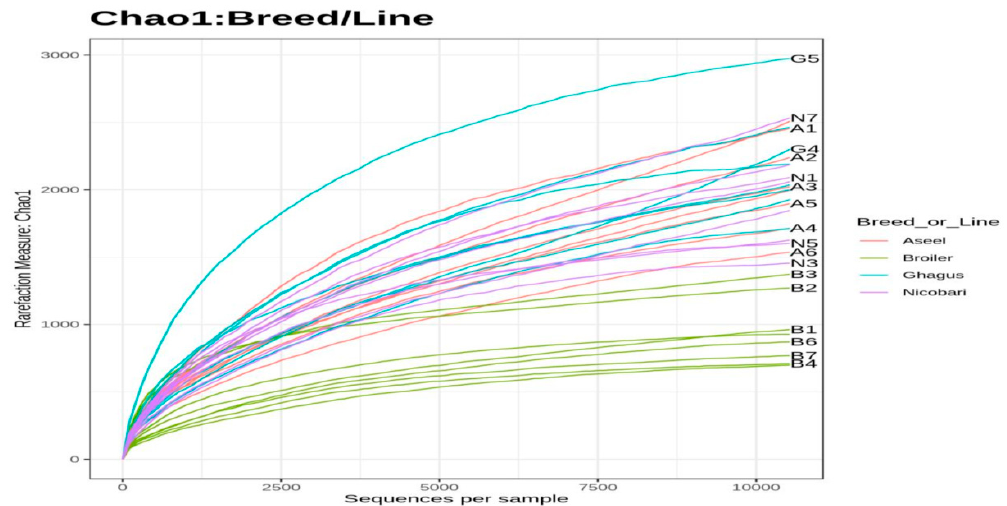
Figure 2. Rarefaction curves based on Chao1. Sequences were rarefied to the minimum library size (at 12,151 sequences